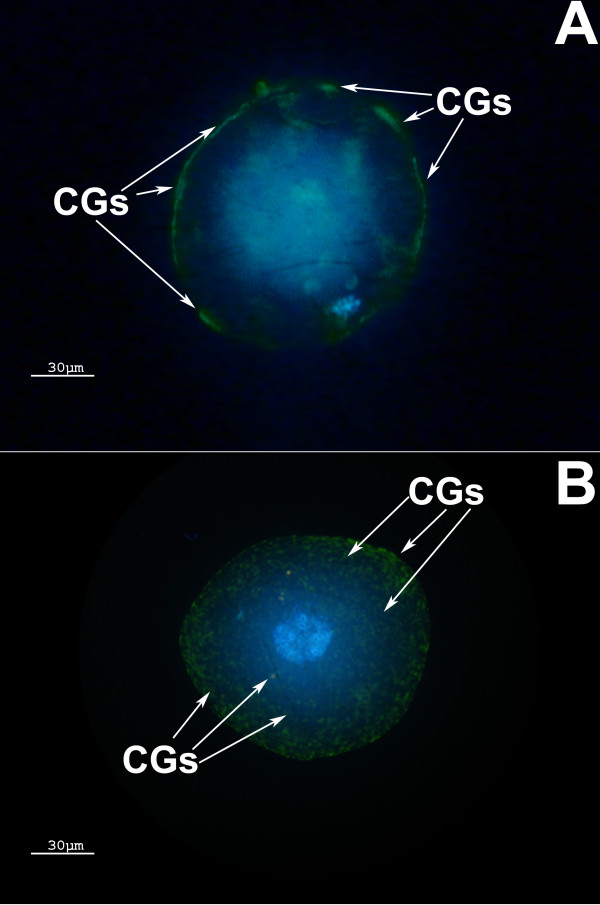
Cytoplasmic Maturation. (A) Complete cytoplasmic maturation: CGs are located on the MII oocyte periphery. (B) Incomplete cytoplasmic maturation: CGs are both clustered in the center and on the periphery of the MII oocyte. CGs = cortical granules